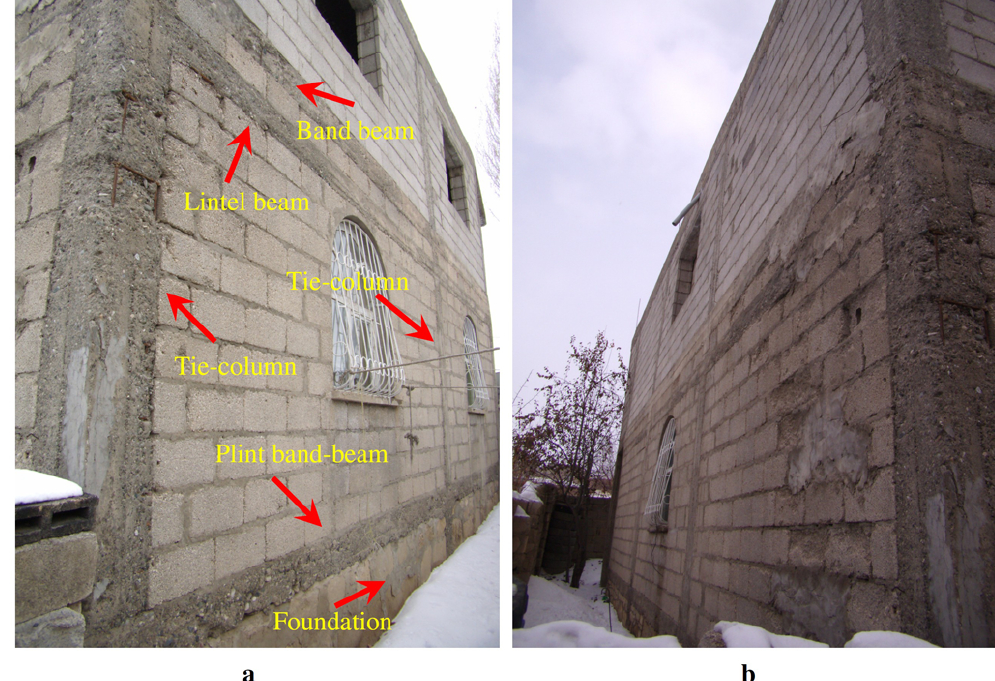
Fig. 25. Views of a typical confined masonry building and its structural members.